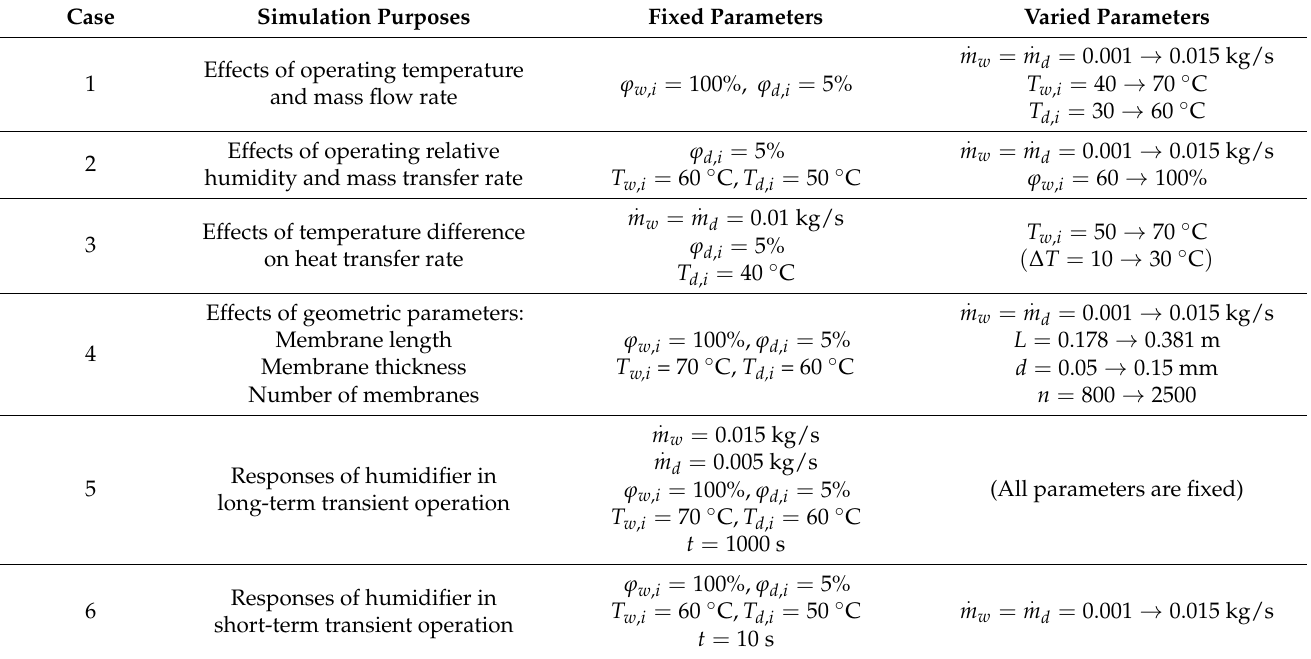
Table 2. Description of simulation cases and